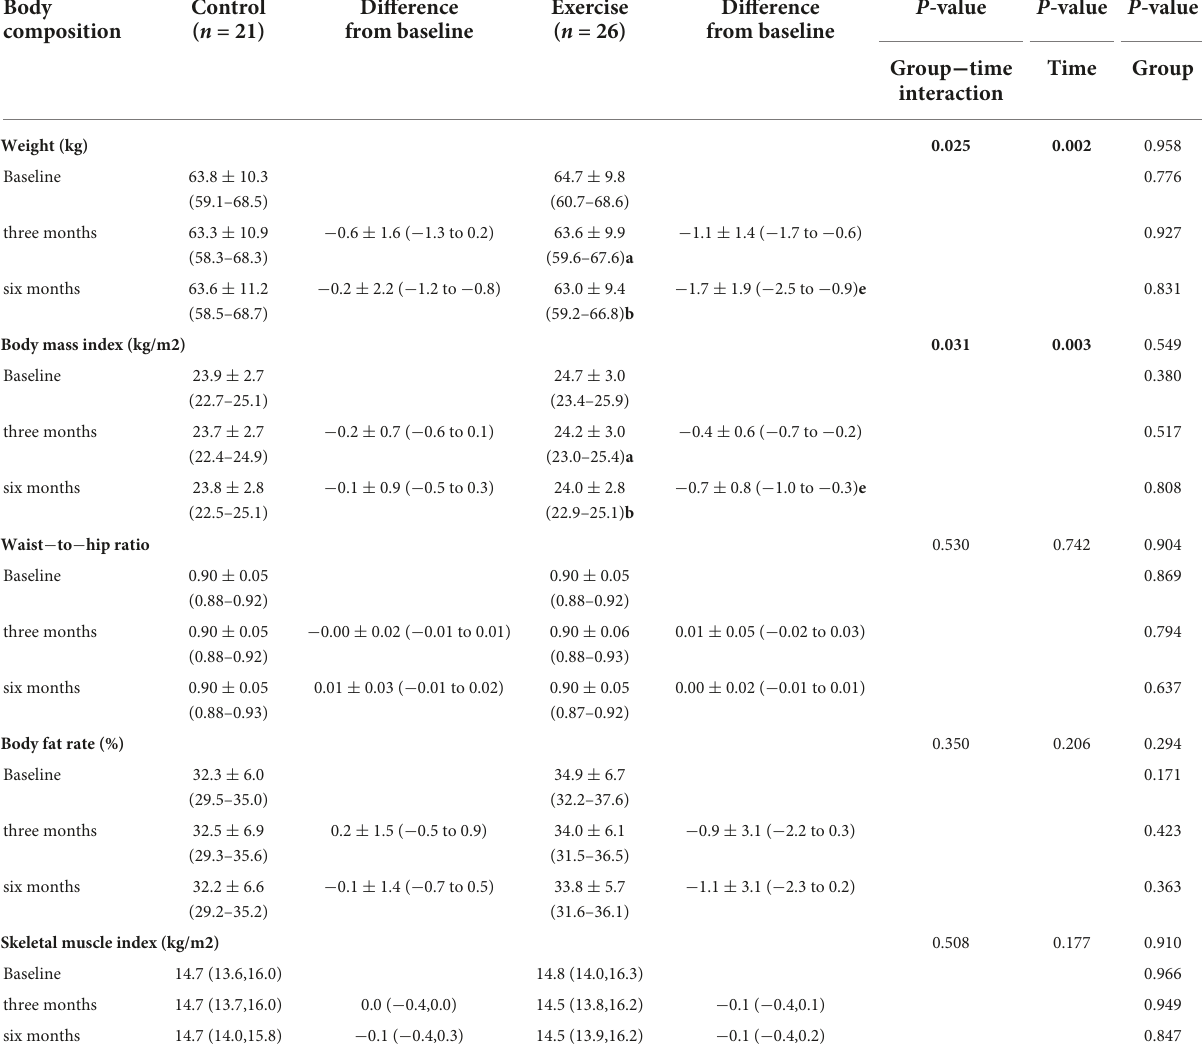
TABLE 3 Effect of Yijinjing combined with resistance exercise on body composition in the study’s participant. Body Control composition ( n =